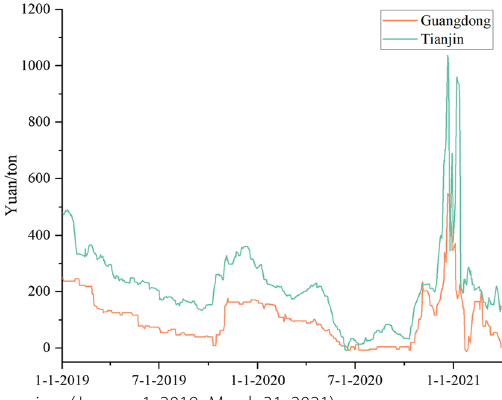
Fig. 2 Energy-switching prices (January 1, 2019–March 31,